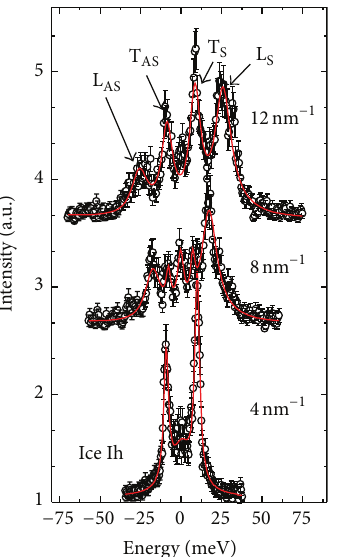
Figure 7: The spectrum of polycrystalline ice Ih measured in [11] at some selected 𝑄 s (open circles) is compared with corresponding best fit model line-shapes. The letters “T” and “L” label, respectively, thetransverseandlongitudinalpeaks,whilethesuffixes“S”and“AS” indicate, respectively, the “Stokes” and “anti-Stokes” components.